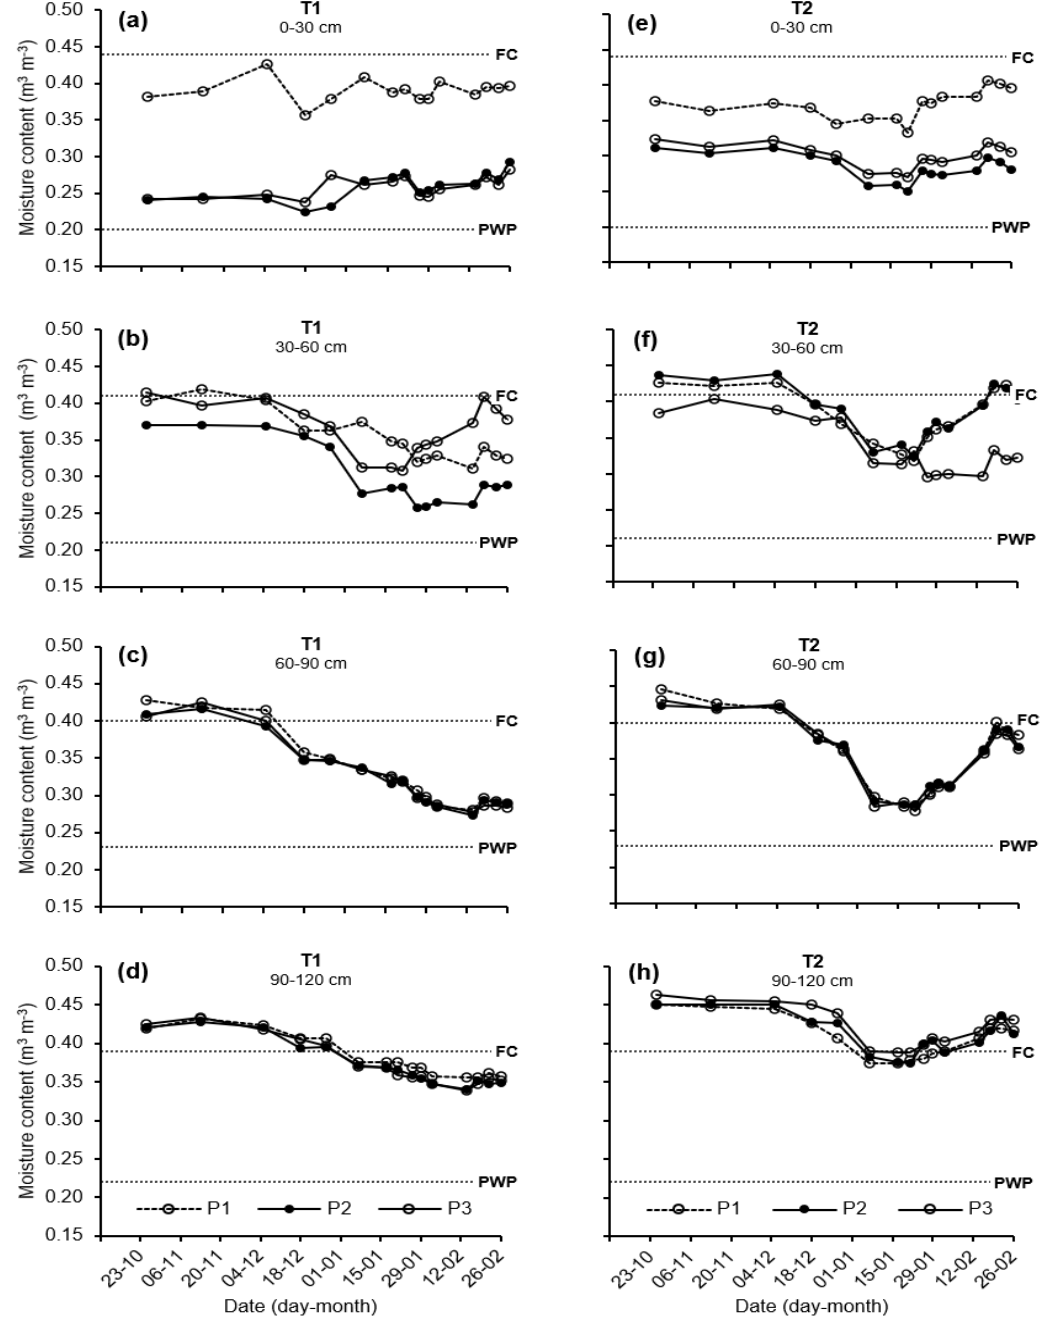
Figure 7. Cycles of soil moisture content before irrigation in the ( a , e ) 0–30 cm, ( b , f ) 30–60 cm, ( c , g ) 60–90 cm, and ( d , h ) 90–120 cm strata throughout the 2008–2009 irrigation season for two drip irrigation treatments of ‘Brookfield Gala’ apple trees. T1: Irrigation with a theoretical volume required by the plant. T2: Irrigation with farm protocol. Each point is the average of 12 readings. FC is field capacity and PWP is permanent wilting point. The moisture content measurement points are P1: 60 cm from the trunk between rows, P2: 30 cm from the trunk within the row, and P3: 60 cm from the trunk within the row.